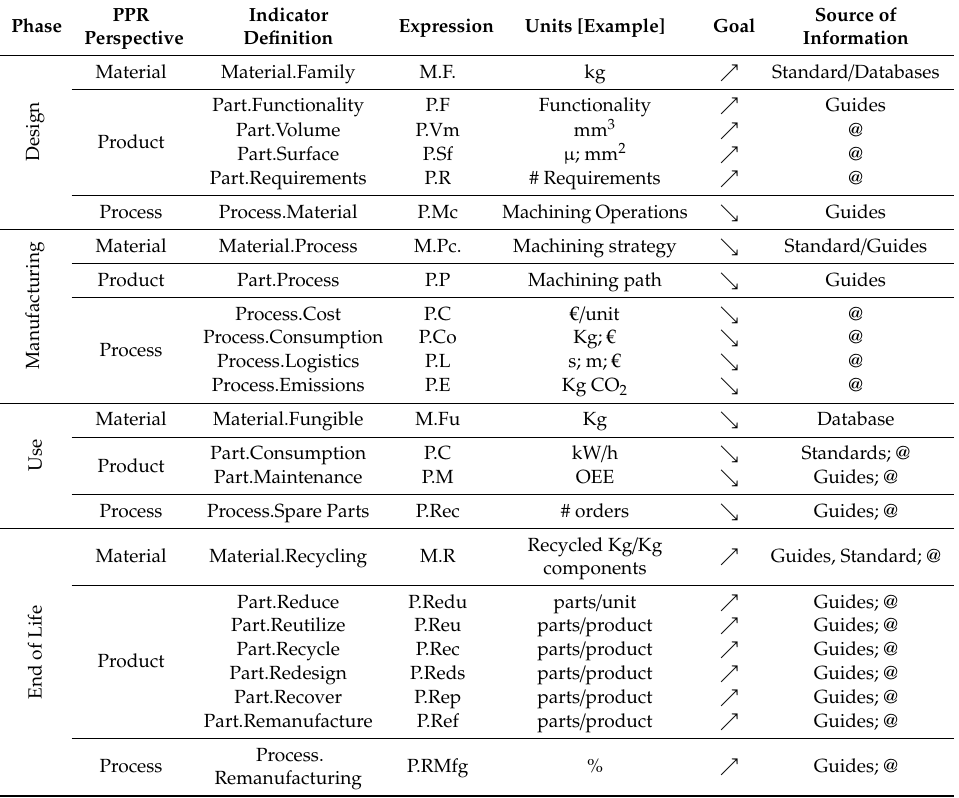
Table 8. Specific information regarding the Indicators from the main life cycle